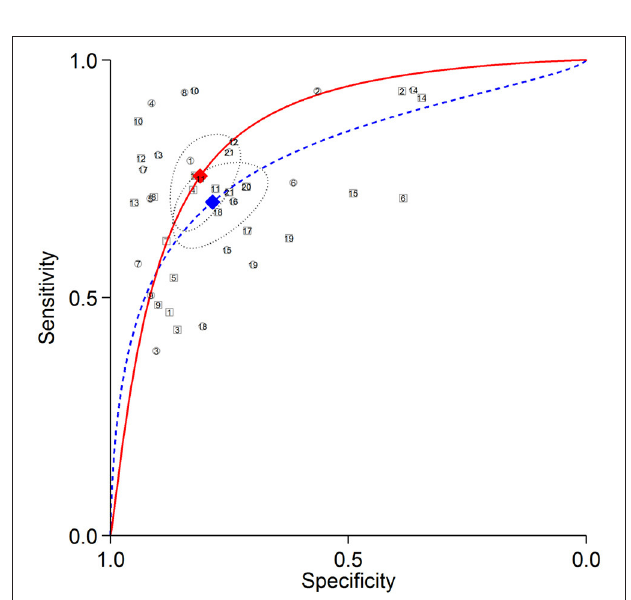
FIGURE 5 | Summary ROC curves of detecting RCA stenosis. Comparisons of summary ROC curves between all AC (solid line) vs. all NAC (dashed line). Each circle (AC) and square (NAC) represent an individual included study. Diamonds represent summary operating points of pooled sensitivity and specificity. AC, attenuation correction; CAD, coronary artery disease; NAC, non-AC; RCA, right coronary artery; ROC, receiver operating